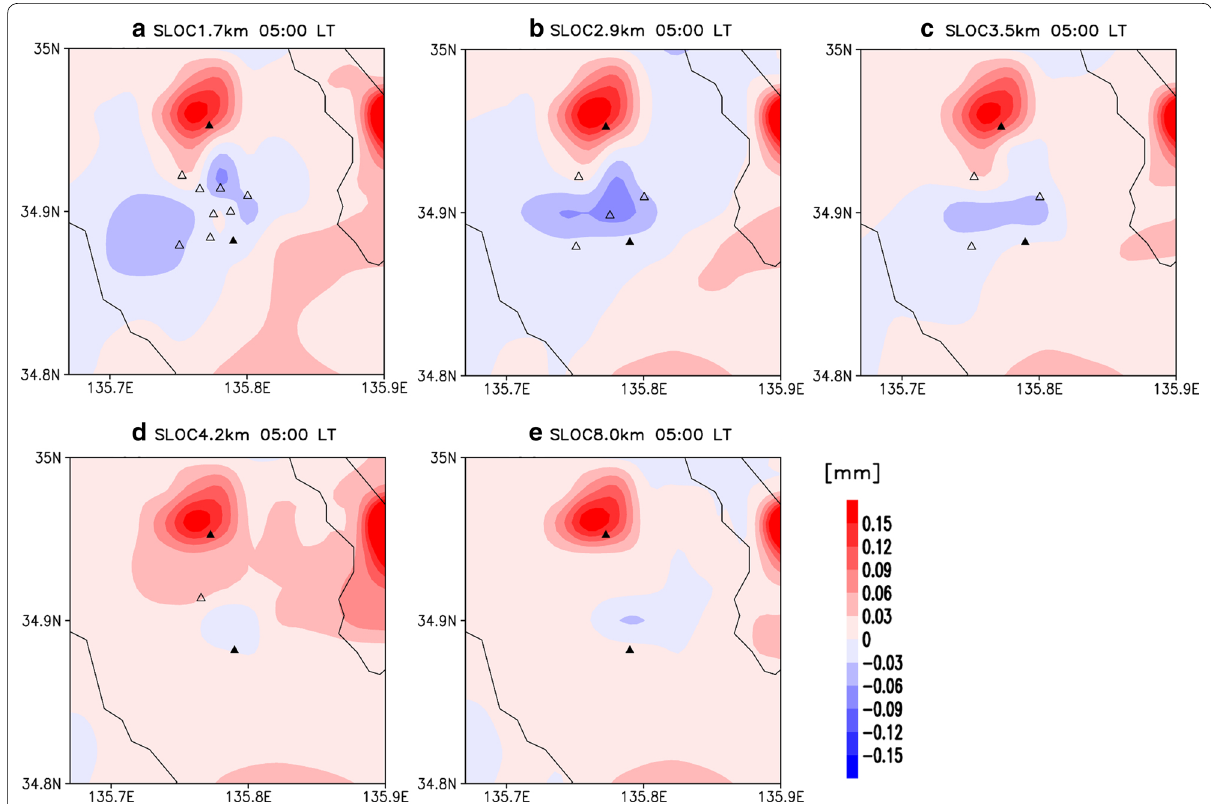
Fig. 11 Distributions of the analysis increment of PWV at 0500 LT on August 14, 2012, analyzed by the SLOC experiments that assimilated PWV SPD-H at the stations indicated by triangle symbols. Open triangles and filled triangles indicate stations of the Uji network and GEONET,